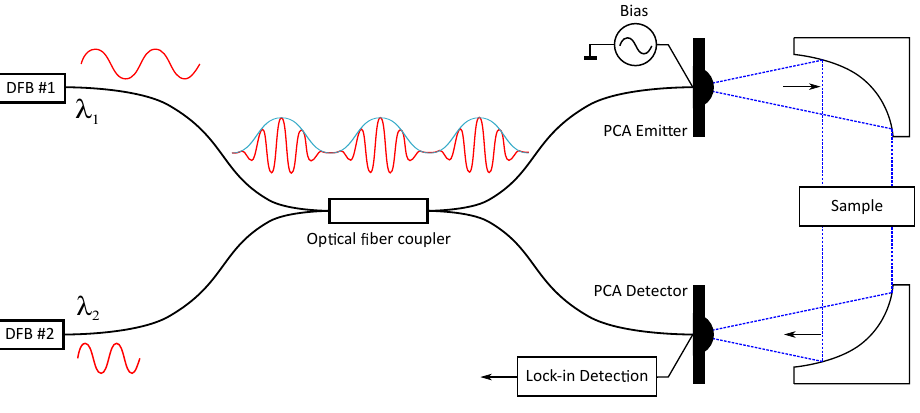
Figure 1. The basic structure of the CW-THz